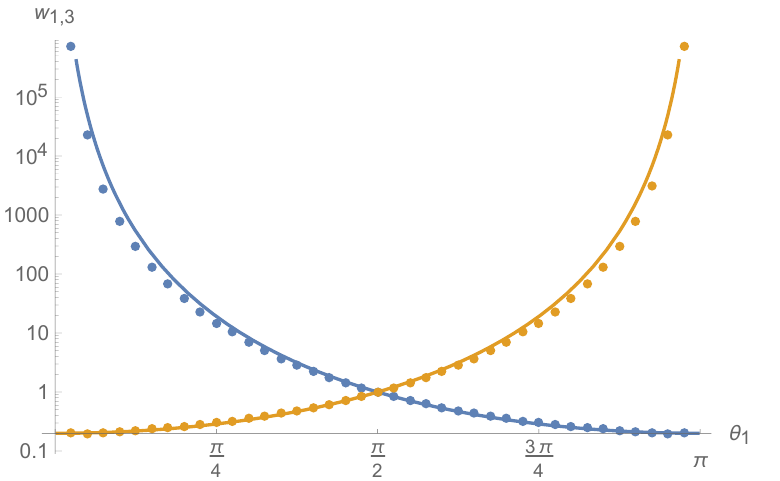
Figure 3 . A graph of w 1 , 3 as functions of θ 1 . The dots represent the data obtained by numerically solving the integral equations with λ = 1000